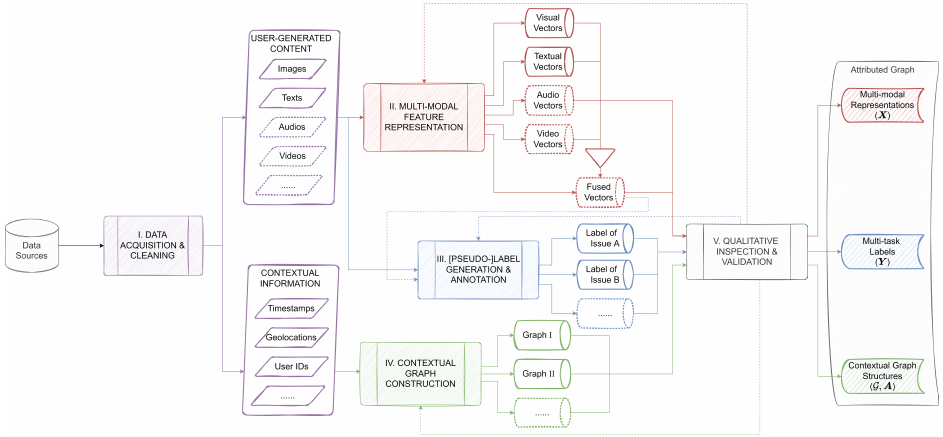
Figure 1. The framework to create multi-modal machine learning datasets as attributed graphs from unstructured data